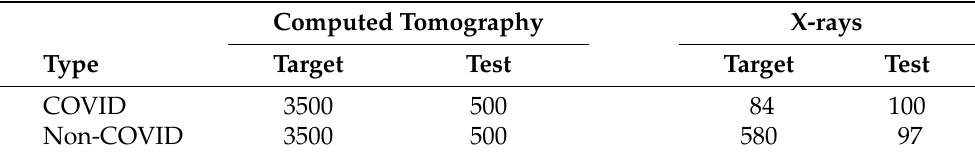
Table 2. Number of target and test images for each considered class and